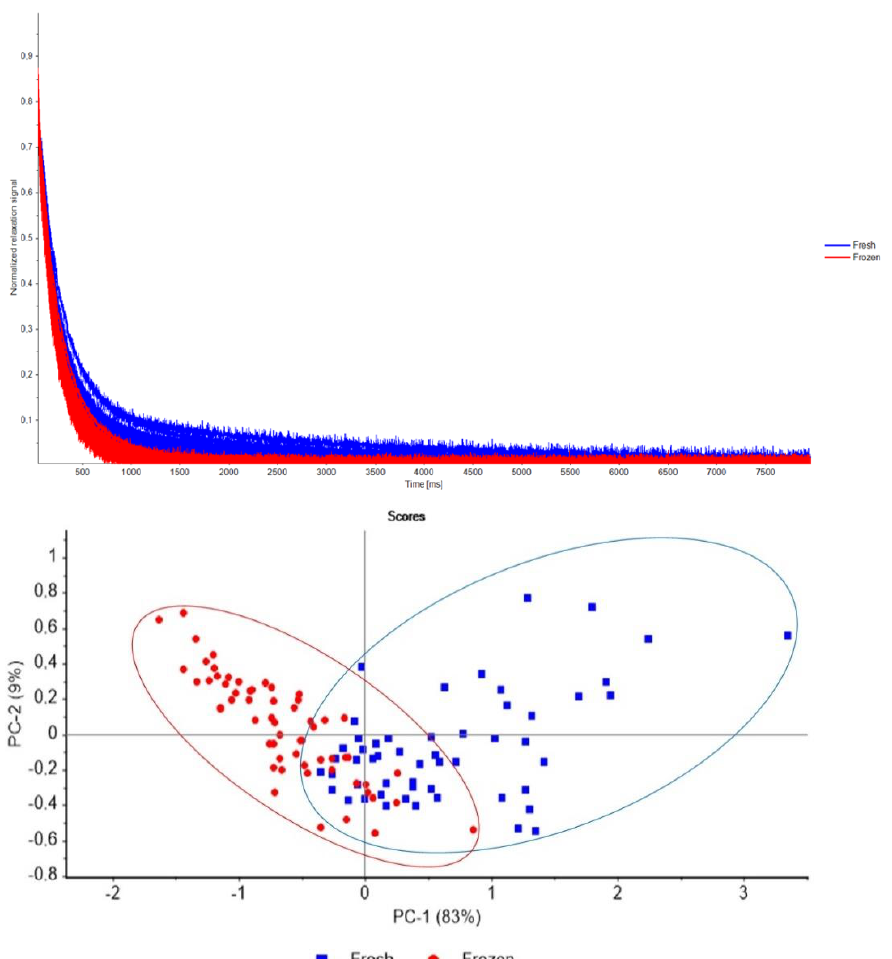
Figure 3. ( upper panel ) Normalised transversal relaxation curves obtained with LF-NMR for fresh and frozen lamb meat samples, and ( lower plot ) principal component analysis (PCA) plot of these relaxation curves. The blue ellipse indicates the grouping of fresh meat samples, and the red ellipse indicates frozen meat samples. Table 3. Transverse relaxation times (T 2i , i = [b, 1, 2]) and apparent proton populations (A 2i ,) obtained through multi-exponential fitting of the LF-NMR relaxation data for the fresh and frozen lamb meat samples (mean ± standard deviation; n = 18 for fresh, n = 20 for